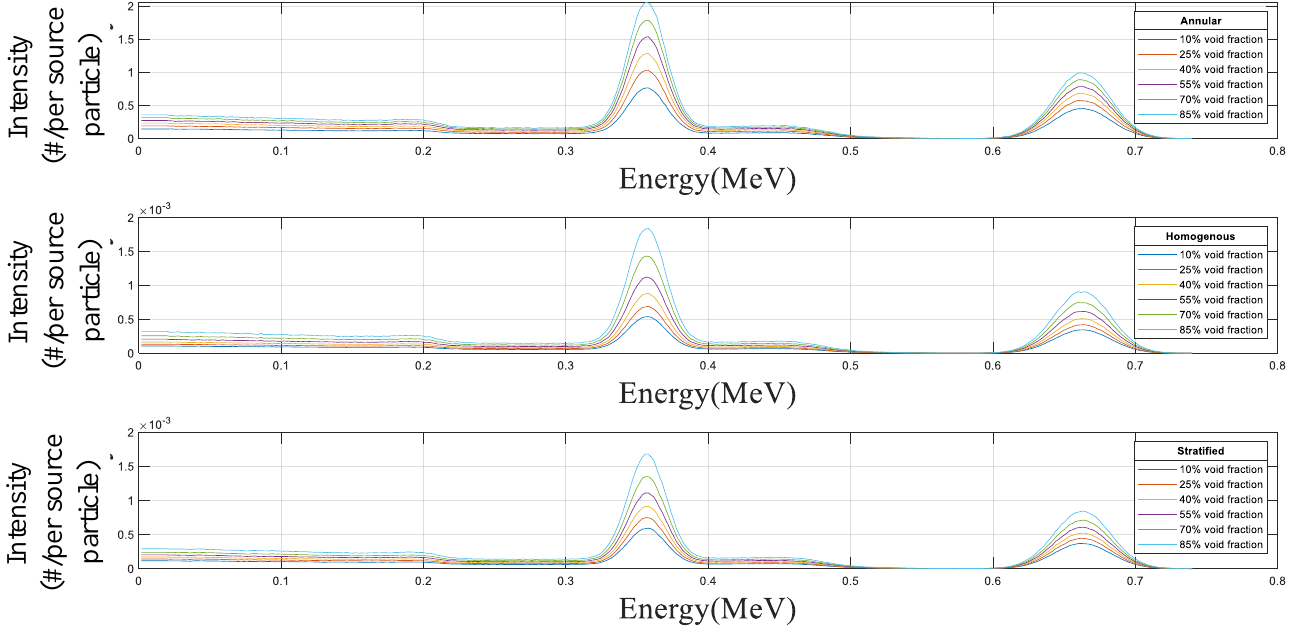
Figure 3. The recorded signal by the detector for all three simulated regimes at 1 cm scale thickness in different void fractions.